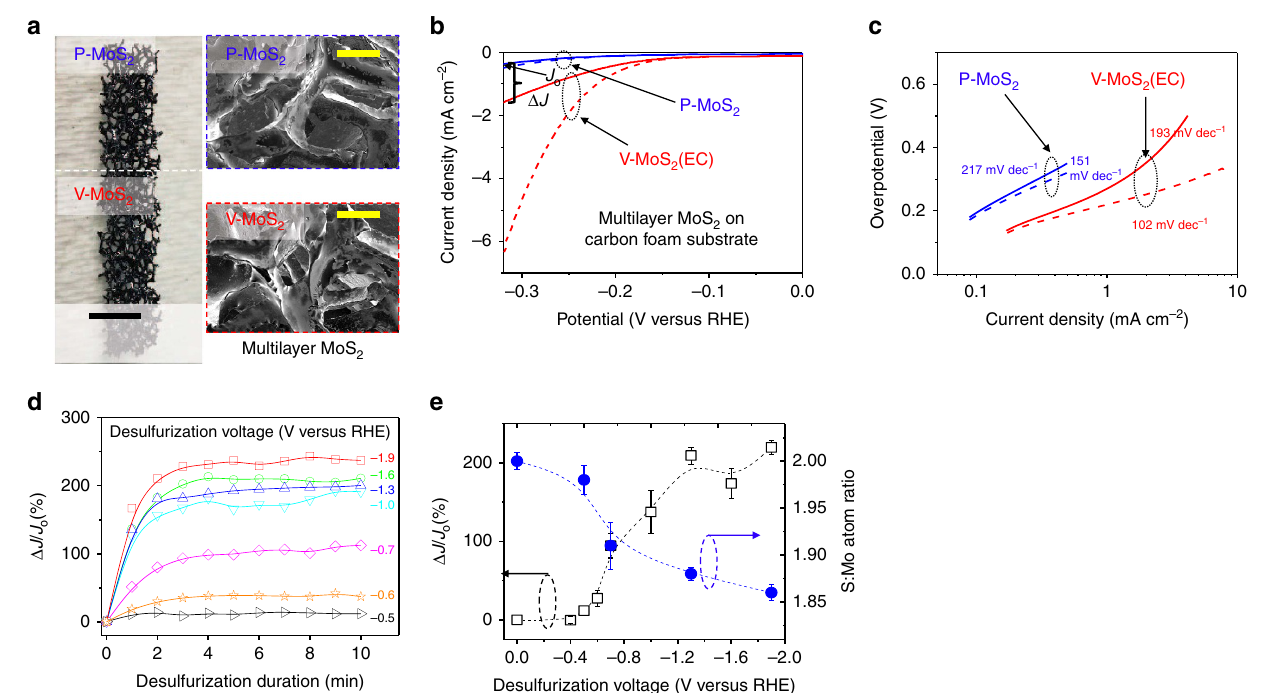
Figure 4 | HER activity before and after desulfurization of polycrystalline multilayer 2 H -MoS 2 . ( a ) Optical (left panel; scale bar, 0.5cm) and SEM images (right panel; scale bar, 0.5mm) of multilayer MoS 2 film on carbon foam before (P-MoS 2 , upper panel) and after (V-MoS 2 , lower panel) desulfurization at (cid:2) 1.3V versus RHE for 60s. ( b ) LSV of multilayer MoS 2 on carbon foam before and after desulfurization, respectively. All the current densities are defined based on the total electrode surface area. The current density increment is defined as D J / J 0 , where J 0 is the current density at (cid:2) 0.32V versus RHE before desulfurization. The J–Vcurves after iR correction are plotted using dashed curves for comparison. ( c ) The corresponding Tafel plot of the curves in b . The calculated Tafel slopes are labelled for each curve. ( d ) Current density increment versus desulfurization duration at various desulfurization voltages from (cid:2) 0.5 to (cid:2) 1.9V versus RHE. ( e ) Current density increment (left, y axis) and S:Mo atom ratio (right, y axis) versus desulfurization voltage at fixed desulfurization duration of 10min. The error bars represent the s.d.’s.